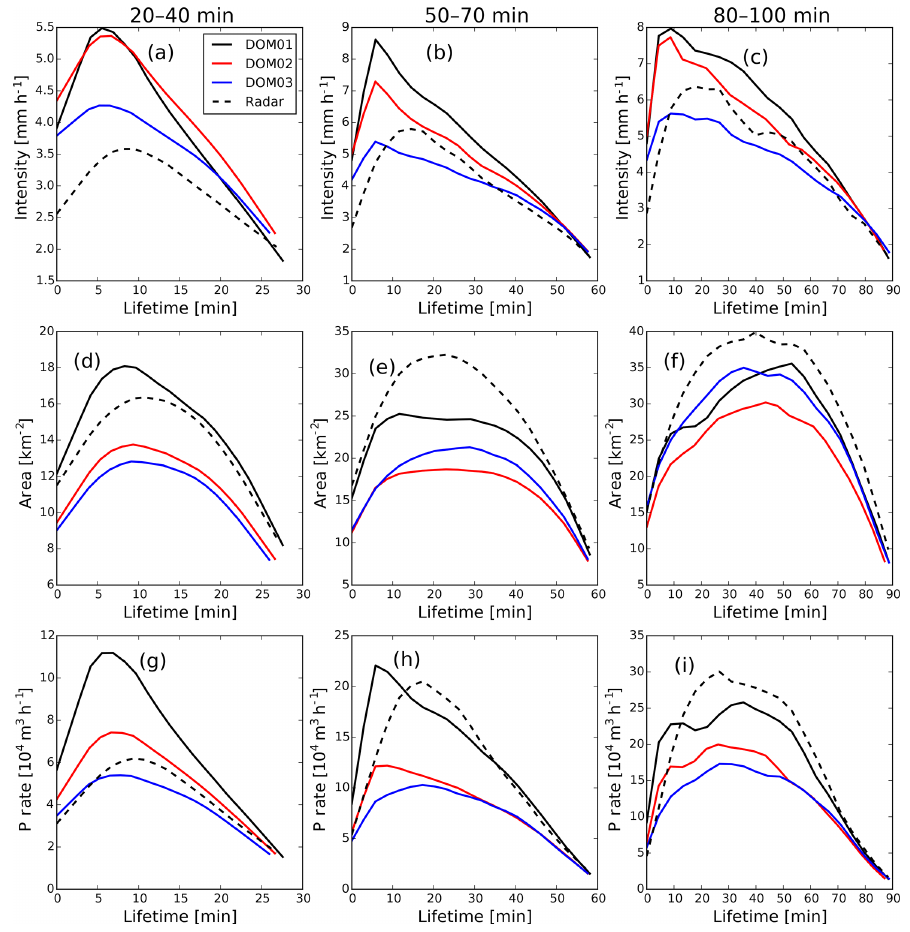
Figure 5. Life cycles of track composites (including the days 29 May, 3 June, and 6 June) for solitary tracks of different track duration for model results in three domains with 625m (DOM01), 312m (DOM02), and 156m (DOM03) grid spacings and for radar results. Curves show mean track life cycles of area-mean precipitation intensity (a–c) , area of precipitation objects (d–f) , and rate of total precipitation (that is the areal integral of local precipitation intensity over the object extent) (g–i) , conditioned on tracks with durations between 20 and 40min (a, d, g) , between 50 and 70min (b, e, h) , and between 80 and 100min (c, f, i)